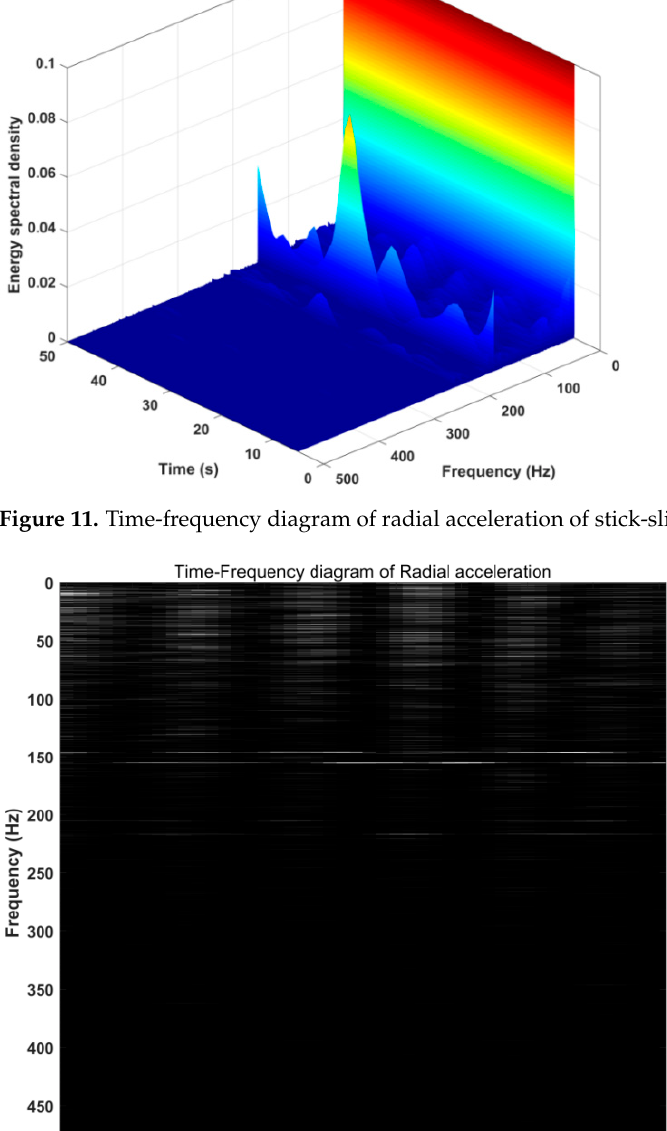
Figure 10. Three ‐ axis acceleration frequency spectrum of stick ‐ slip vibration.